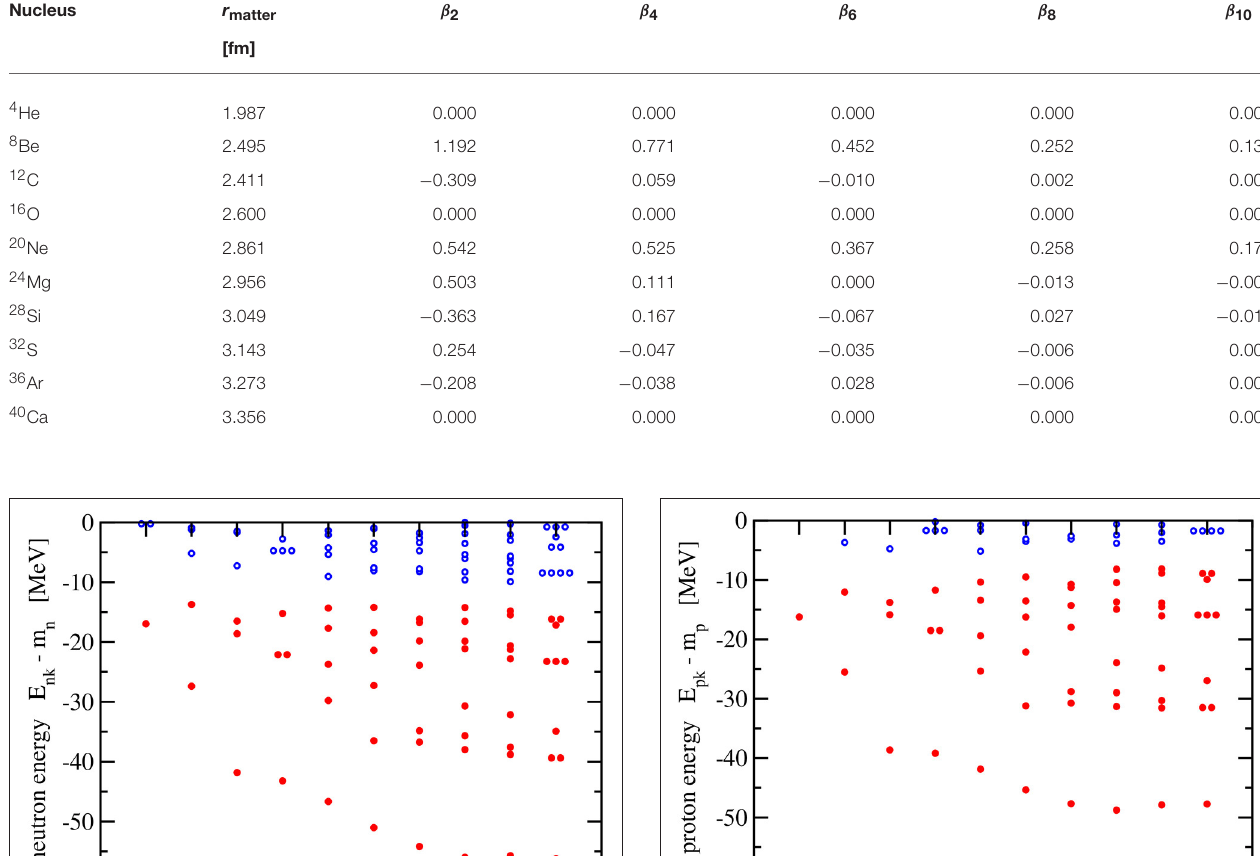
TABLE 4 | Point matter radius r matter and deformation parameters β 2 , …, β 10 for nuclei 4 He, …, 40 Ca. Nucleus